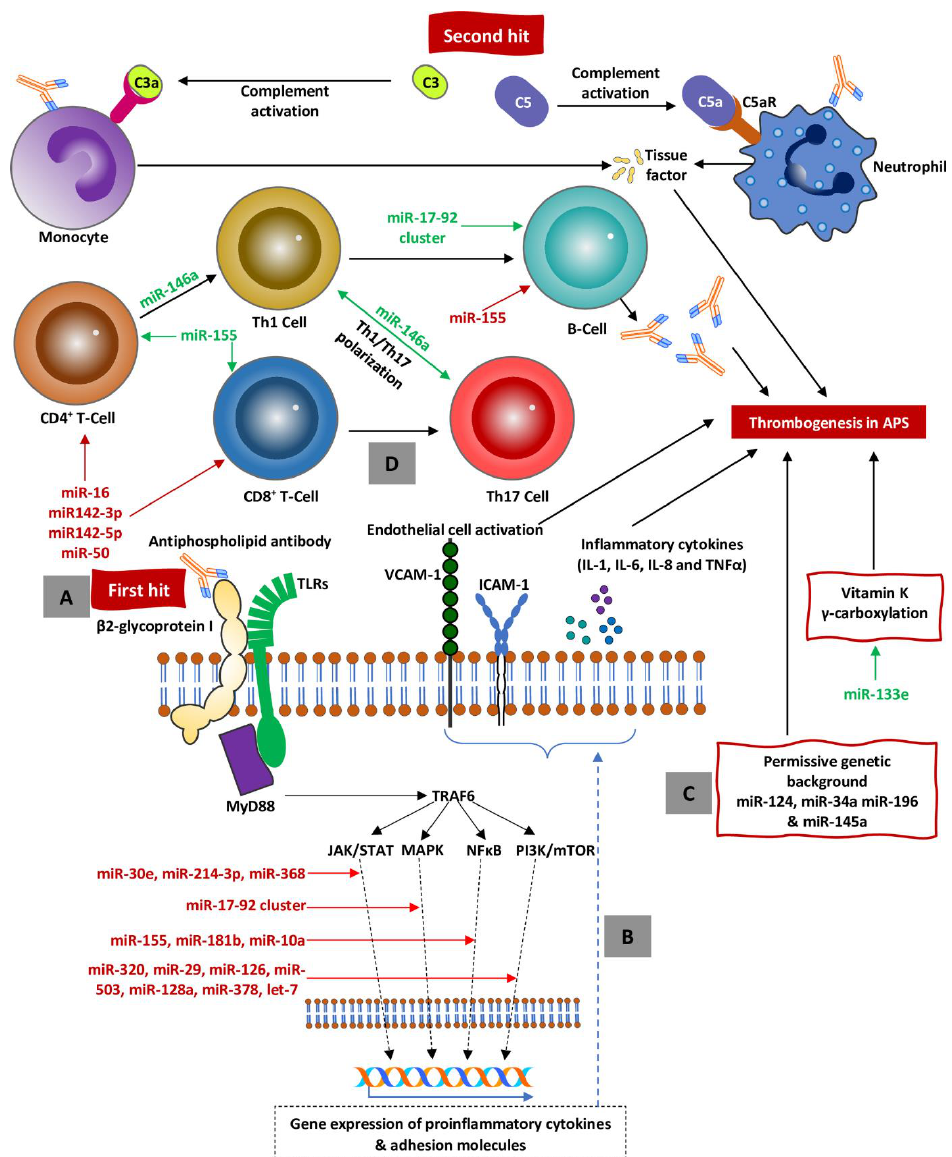
Figure 1. A. A partially unknown stimulus referred to as a first hit (i.e., DAMPs, PAMPs, and aPLs) stimulates TLRs, which in turn activate signal pathways resulting in activation of proinflammatory cytokine genes. B. As the result of inflammatory gene activation, synthesis of inflammatory cytokines and expression of adhesion molecules (i.e., ICAM-1 and VCAM-1) on the endothelium surface occurs. C. Permissive background creates procoagulatory milieu to perpetuate a shift towards coagulation and endothelial damage. D. As the result of suppression of regulatory miRNA (marked in red), the immune system is shifted towards active proinflammatory response with Th polarization toward Th1 and Th17 responses, subsequent activation of B-cells, and autoantibody secretion (including aPLs) causing inflammatory storm (activation of endothelium and clothing factors). All the crucial steps are precisely regulated at the level of miRNAs, which mainly suppress (red text) but also (to a lesser degree) activate (green text) procoagulation. Abbreviations: miRNAs = microRNAs, APS = antiphospholipid syndrome, PAMPs = pathogen-associated molecular patterns, DAMPs = danger-associated molecular patterns, TLRs = toll-like receptors, TRAF6 = tumor necrosis factor receptor-associated factor 6, JAK / STAT = janus kinases / signal transducer and activator of transcription, NF- κ B = nuclear factor kappa-B, MAPK = mitogen-activated protein kinase, mTOR = mechanistic target of rapamycin, aPLs = antiphospholipid